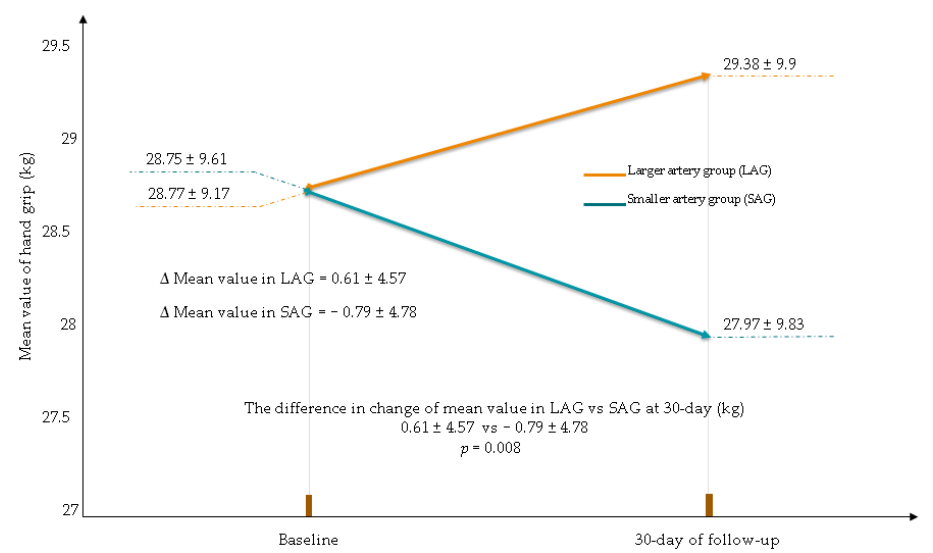
Figure 3. Mean value reduction in hand grip in used hand for CAG/PCI. CAG—coronary angiography, PCI—percutaneous coronary interventions.